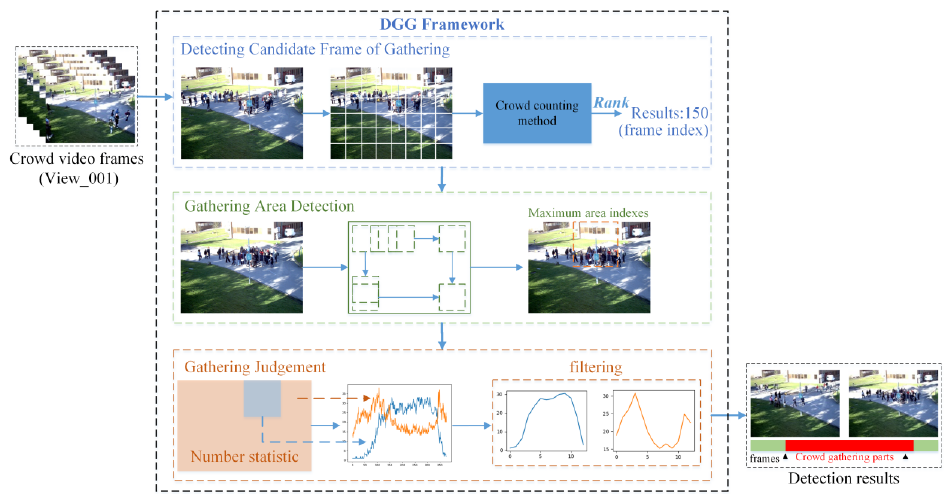
Figure 1. The overview of the proposed DGG for crowd gathering detection.